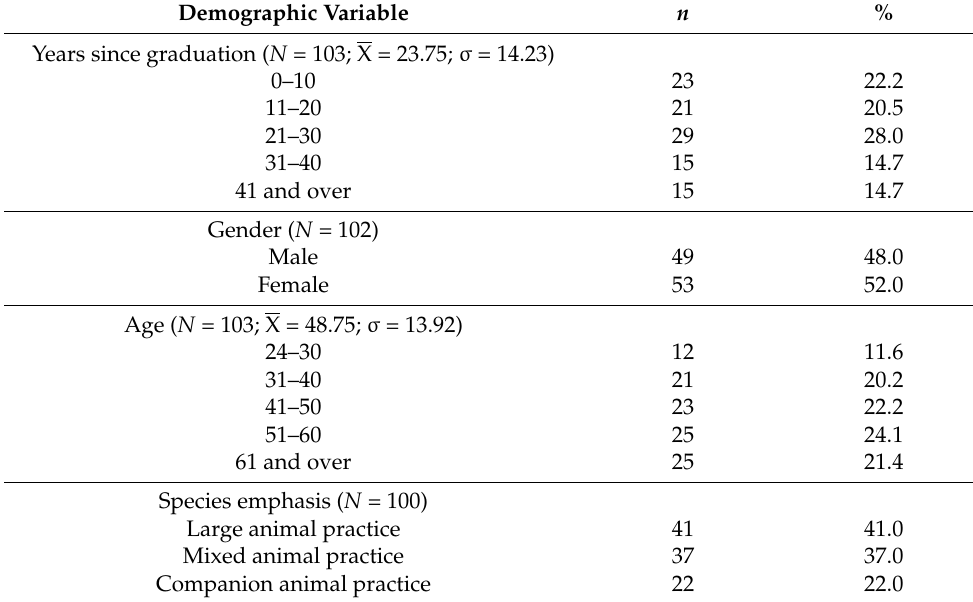
Table 3. An overview of the sample demographics.